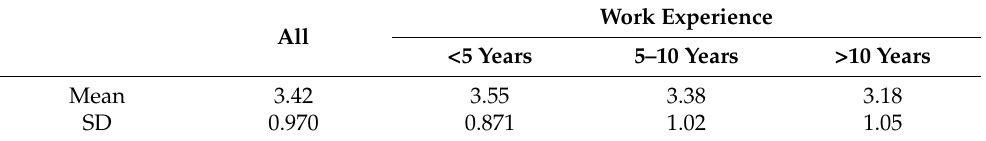
Table 7. Mean and standard deviation of CLP among workers with different work experiences.